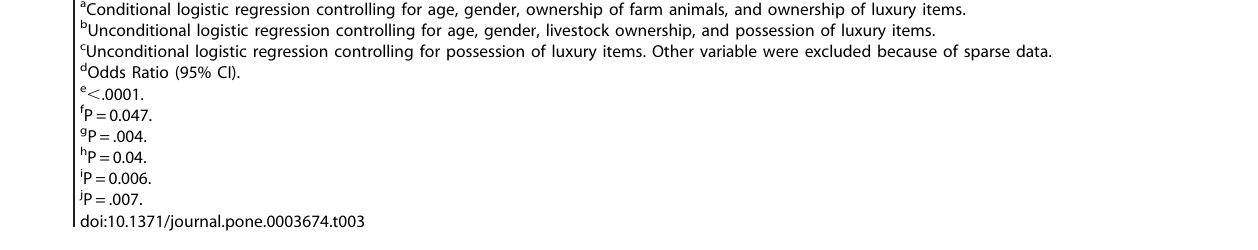
a Conditional logistic regression controlling for age, gender, ownership of farm animals, and ownership of luxury items. b Unconditional logistic regression controlling for age, gender, livestock ownership, and possession of luxury items. c Unconditional logistic regression controlling for possession of luxury items. Other variable were excluded because of sparse data. d Odds Ratio (95%